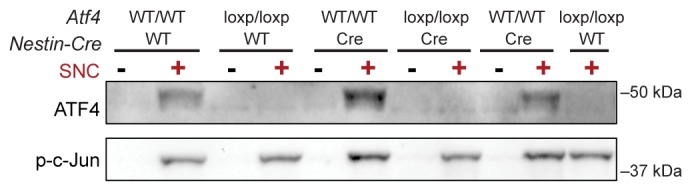
Immunoblots indicate a lack of ATF4 protein induction in L3/L4 DRG 24 hr post-SNC in ATF4loxp/loxp mice, irrespective of the presence of Cre recombinase.